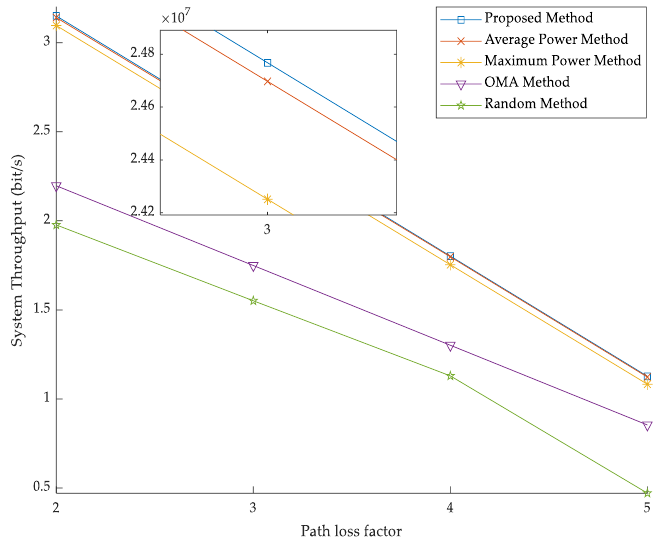
Figure 2. Total system throughput versus path loss factor.